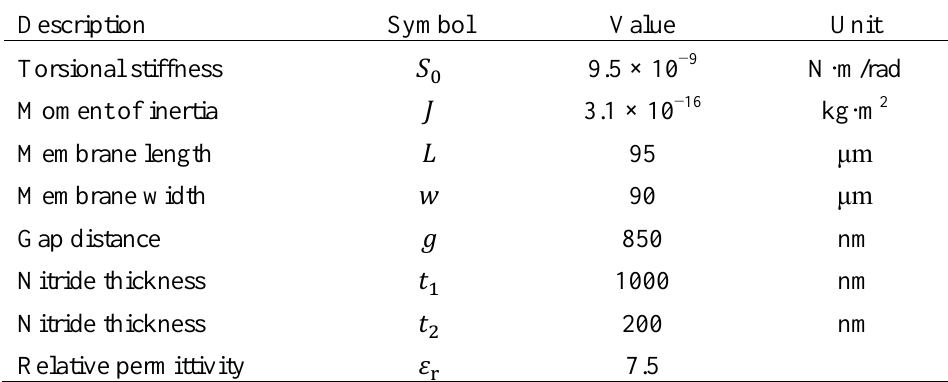
Table 1. Parameter values of the hair mechanical system and the capacitor.